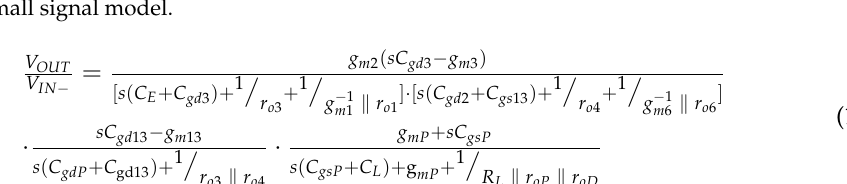
Figure 3. Small signal model.